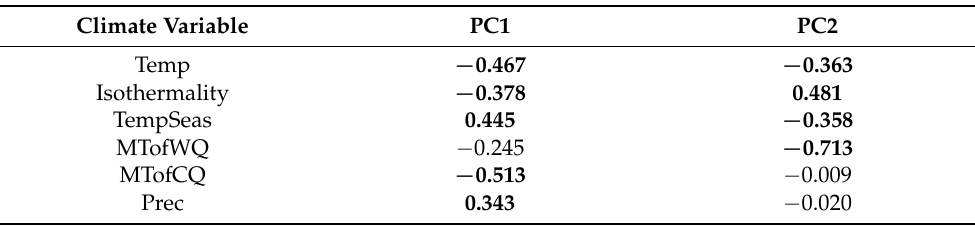
Table 1. Correlation coefficient values between principal components PC1 and PC2 and climate